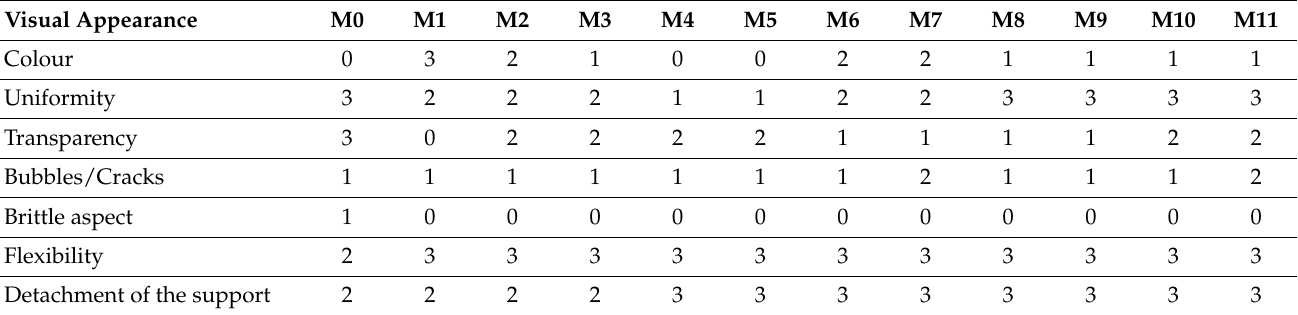
Table 3. Comparison of the visual macroscopic aspect of chitosan membranes and green banana peel extract obtained in the study.